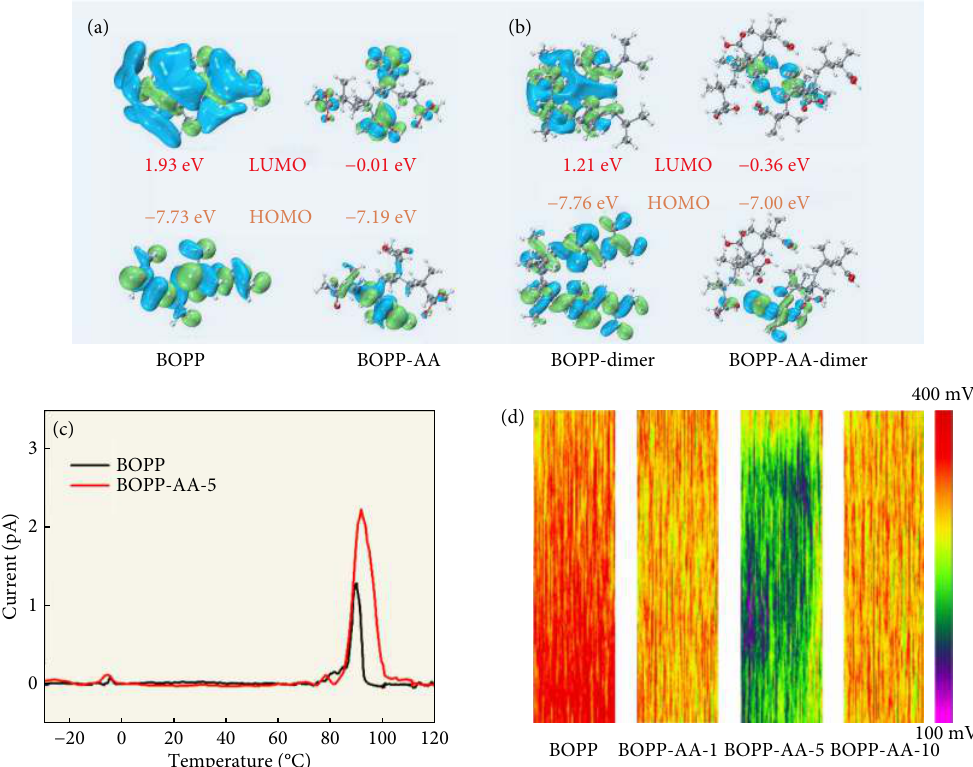
Fig. 5 (a) 3D distribution of the LUMO and the HOMO energy levels of BOPP and BOPP–AA. (b) BOPP-dimer and BOPP–AA-dimer. (c) TSDC of BOPP and BOPP–AA-5. (d) KPFM of BOPP–AA